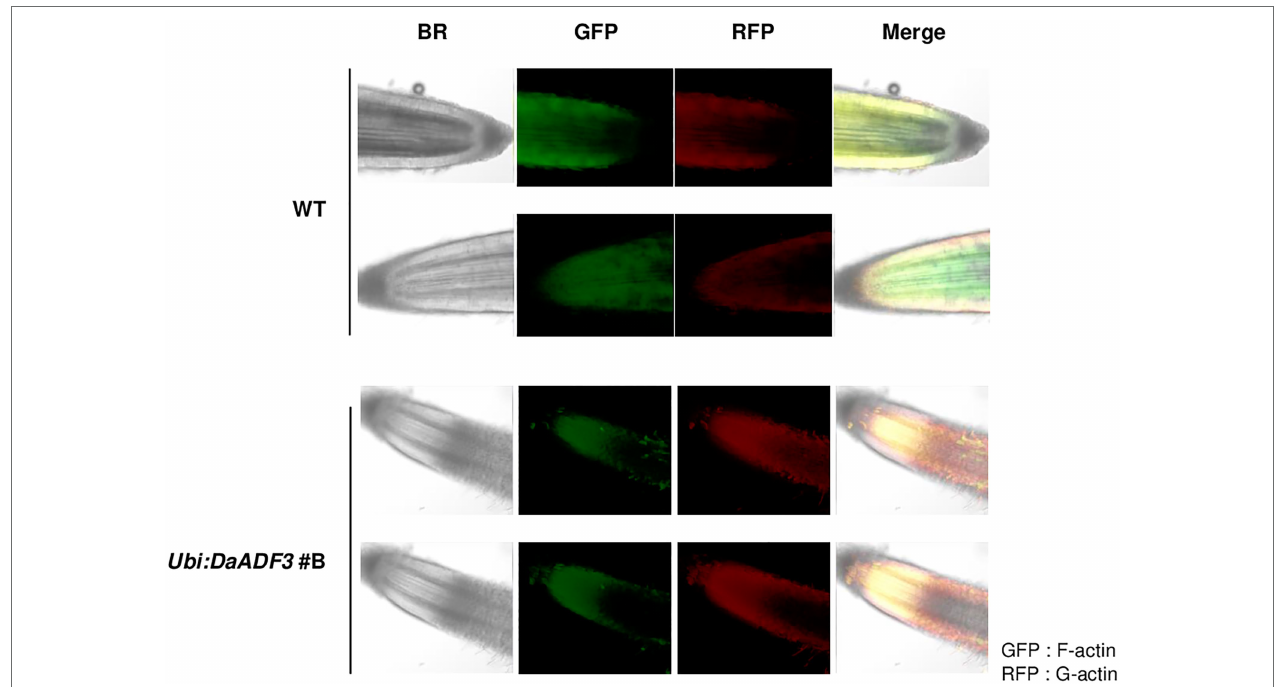
FIGURE 7 | Confocal image of G-actin and F-actin in root tips of WT and Ubi:DaADF3 transgenic rice plants. Pieces of root tissue apices (1 cm) were cut, fixed directly, and incubated in a mixture of Alexa Fluor 488-DNase I and Alexa Fluor 568-phalloidin. The stained samples were observed using a laser scanning confocal microscope. The G-actin and F-actin signals were excited by lasers at 488 (RFP) and 550 nm (GFP),